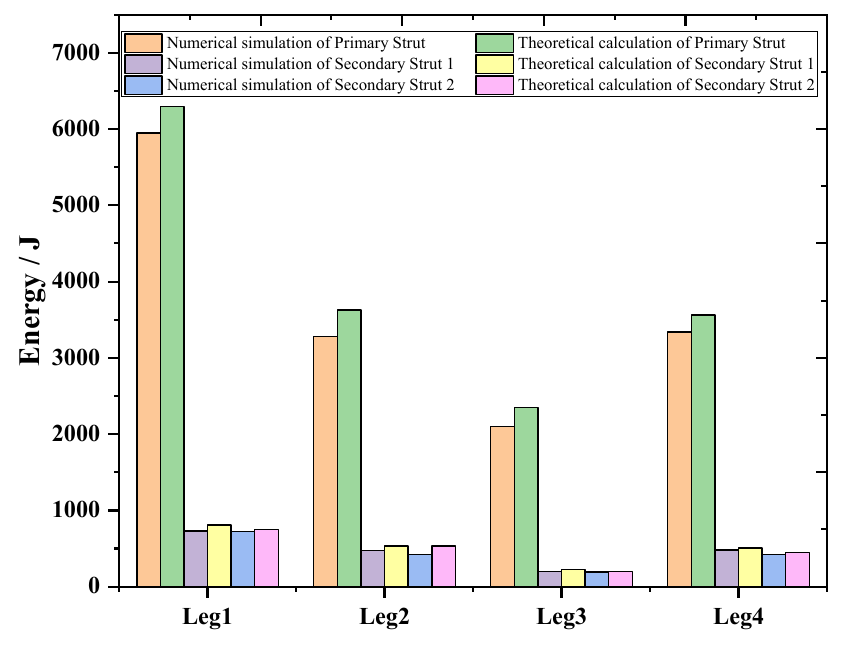
Figure 22. EA of 1-2-1 type landing.